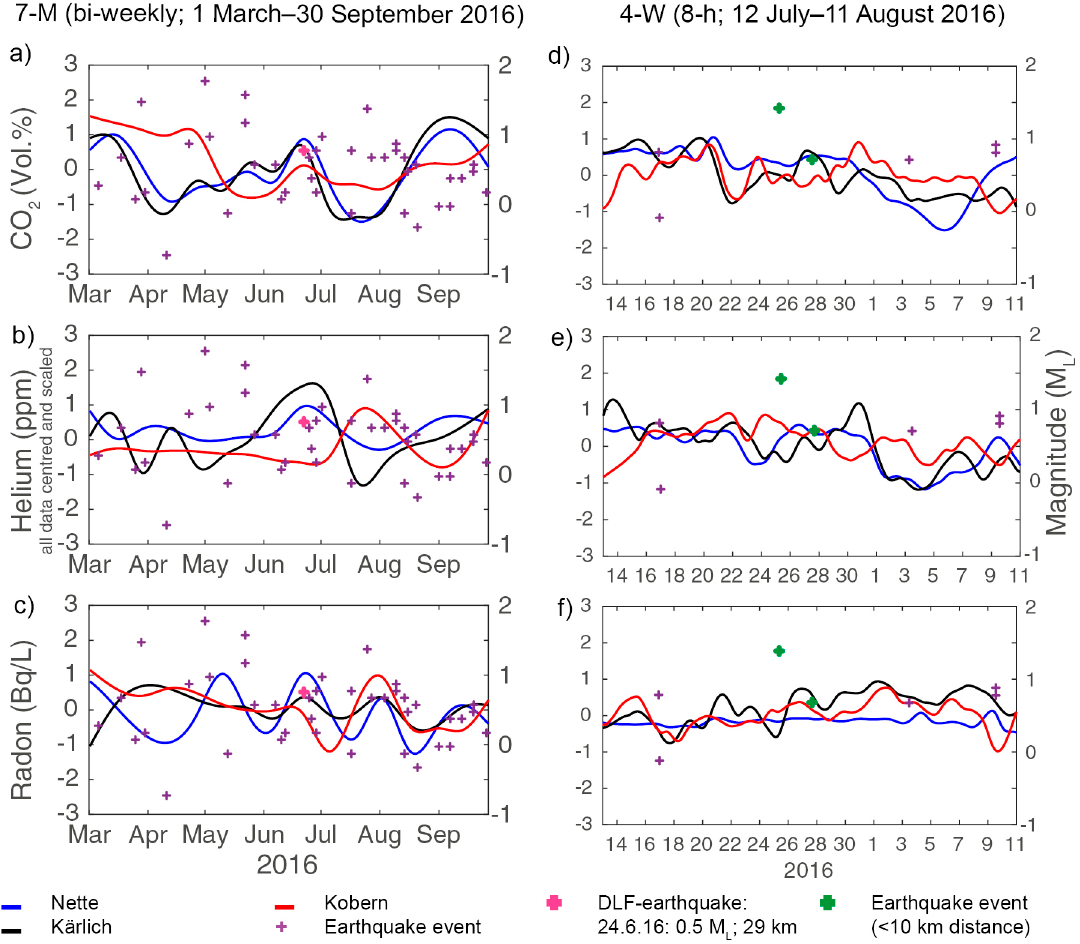
Figure 5. Patterns of gas concentrations (centered and scaled data) during the bi-weekly ( a – c ) and 8-hourly ( d – f ) surveys in the mineral springs and earthquake events (M L ) indicated with purple crosses. The deep low-frequency (DLF) earthquake on 24 June 2016 in Niedermendig is marked in magenta; earthquakes with a distance < 12 km during the 4-W sampling are marked in green.